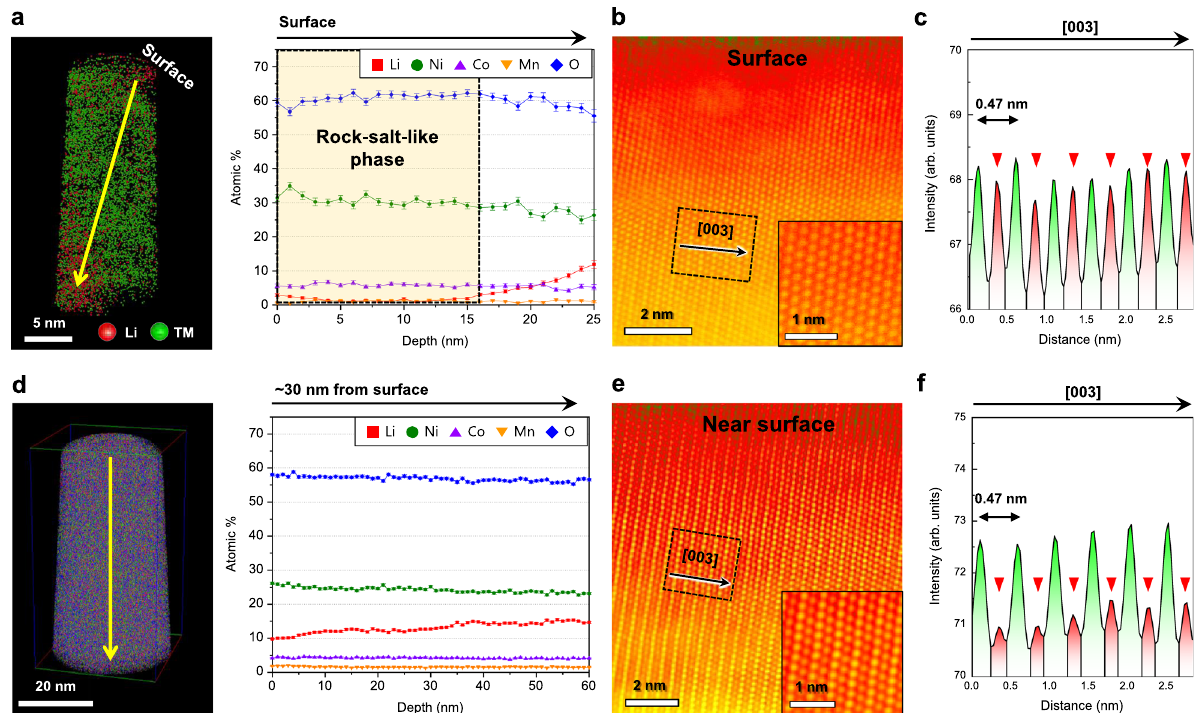
Fig. 3 Evolution of the Li de fi ciency and disordered structure near the surface of NCM-300 cycles. a APT depth pro fi le at the top surface, showing a signi fi cant Li de fi ciency up to ~15 nm (region enclosed by dotted square). b , c STEM-HAADF image ( b ) and intensity pro fi le ( c ) at the top surface. The rock- salt-like phase evolves because of TM migration (inset: magni fi ed image). Red arrows indicate TM migration from 3b to 3a sites. d APT depth pro fi le starting at ~30 nm from the top surface, showing the gradual increase in the Li concentration along the depth. e , f STEM-HAADF image ( e ) and intensity pro fi le ( f ) starting at ~30 nm from the surface (inset: magni fi ed image). The red arrows show that 30 nm below the surface, TMs migrate to a lesser extent than they do near the top surface in ( c ). Error bars show the standard deviation of each